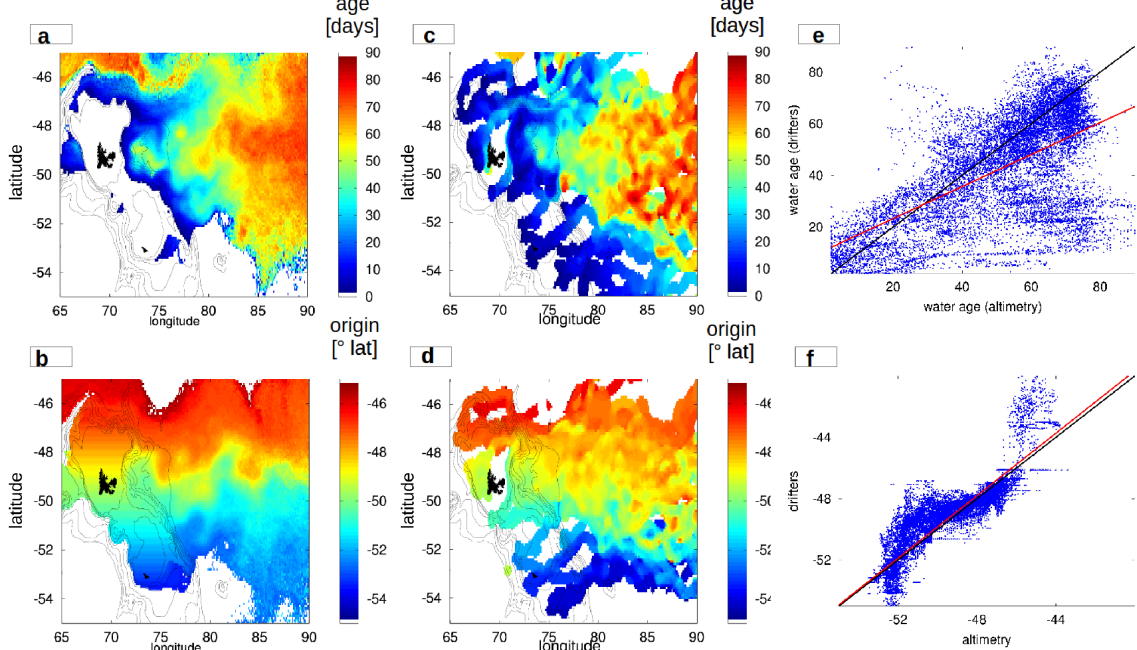
Figure 7. Validation of Lagrangian diagnostics derived from altimetry with the same quantity computed from SVP drifter trajectories. (a– b) Age and origin from the plateau derived from altimetry averaged over spring–summer (October–March) 2001; (c–d) same as (a–b) but derived from trajectories of real SVP drifters deployed during October–November 2011 and January–February 2014. (e–f) Scatter plots of drifter-derived vs. altimetry-derived data for the age and the origin from the plateau, respectively. Table 1. The table provides the extent and the degree of overlap (congruence) for the altimetry-based forecast – defined through the “water age” diagnostic – and the plume visible from remote-sensed chlorophyll (Chl.). The boundaries of the plume are defined, setting threshold values. The thresholds for the forecasted plumes were chosen to match (within 10%) the extension of the chlorophyll plume with typical moderate and high values (0.5 and 1µgL − 1 , respectively). The overlap is 36% for the lower chlorophyll threshold (hence for the larger plume) and 28% for the higher chlorophyll threshold (smaller plume). Threshold Extent of plume Overlap Age Chl. Age Chl.